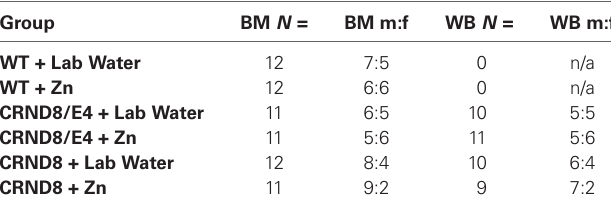
Table 1 | Group distributions and male to female ratio for Barnes maze (BM) and Western blot (WB) analyses .